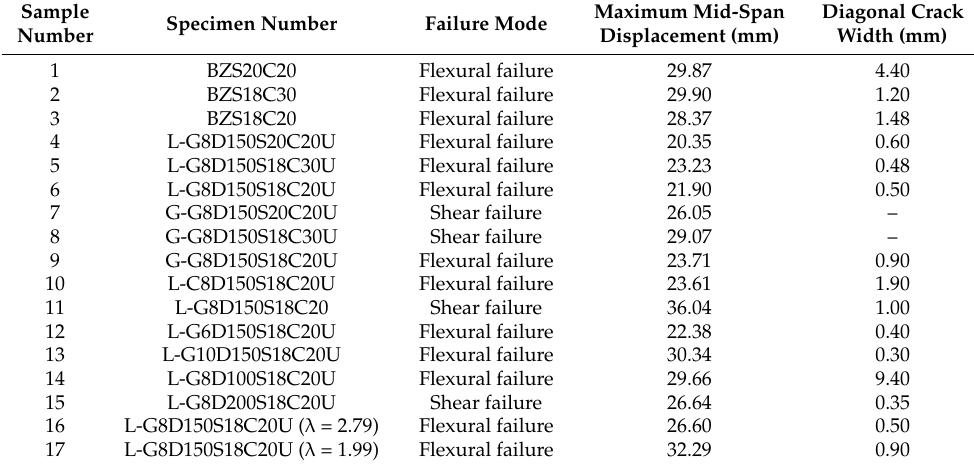
Table 6. Failure modes of specimens.